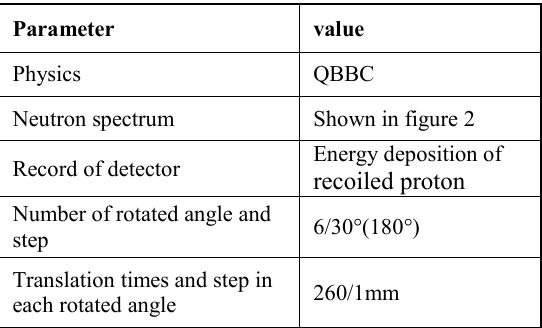
Table 1 . Main simulation parameters of fast neutron